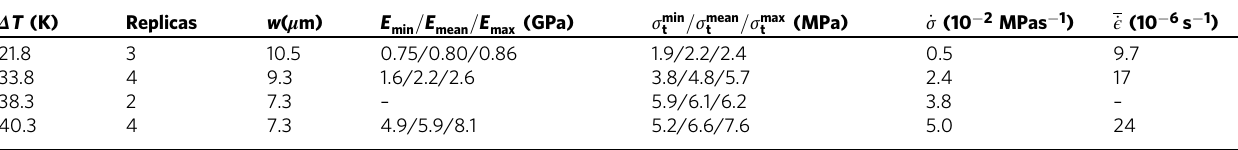
Table 1 Tensile properties of the hydrate shell in monotonic loading